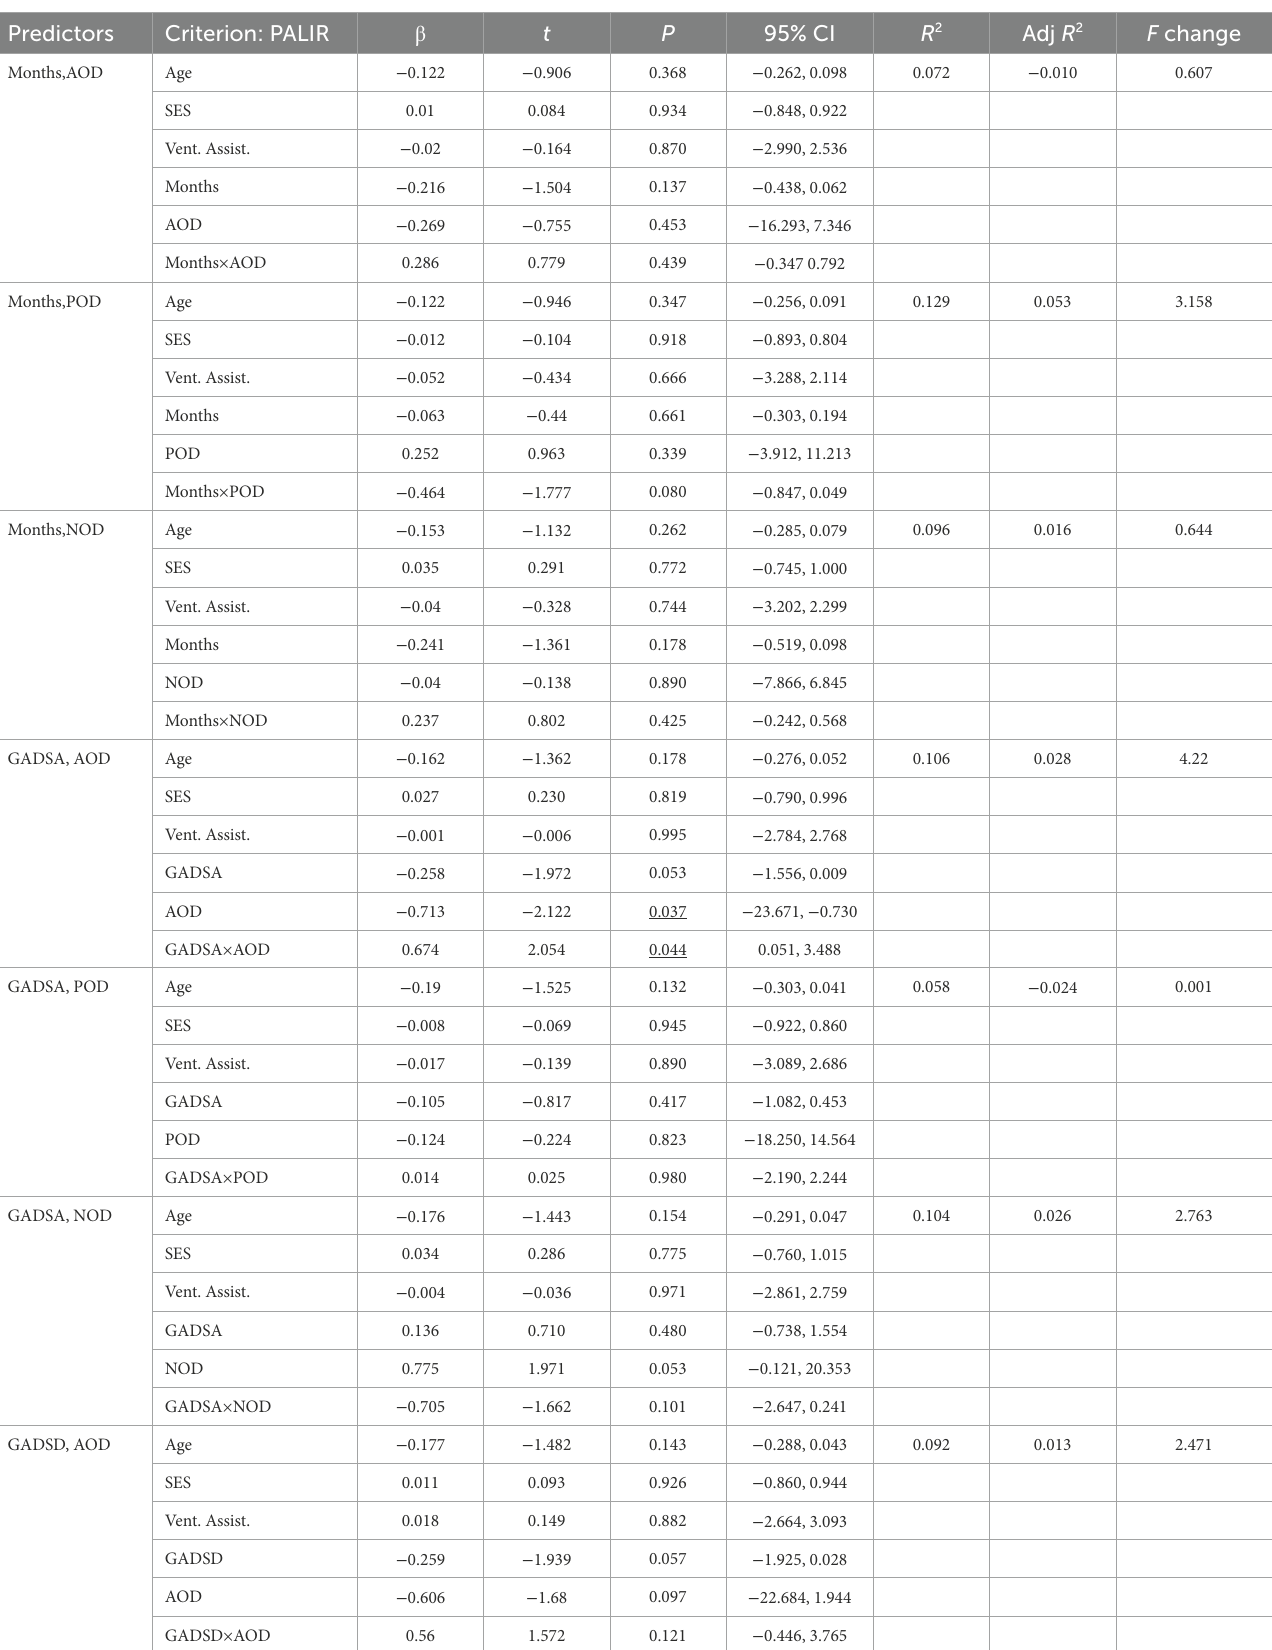
TABLE 7 Multiple regressions predicting immediate ability to recall verbal episodic information (PALIR score), with months since COVID-19 onset, symptoms of anxiety and depression, trait-anxiety, and olfactory dysfunction as predictors.